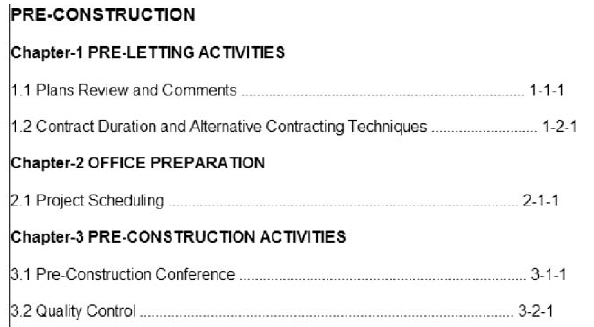
Fig. 3. Sample Document Structure